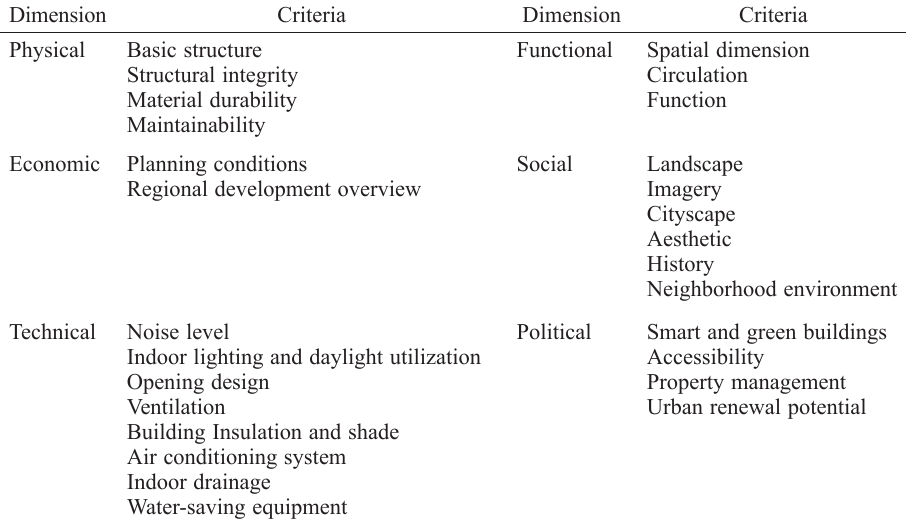
Table 1. Evaluation criteria of building service